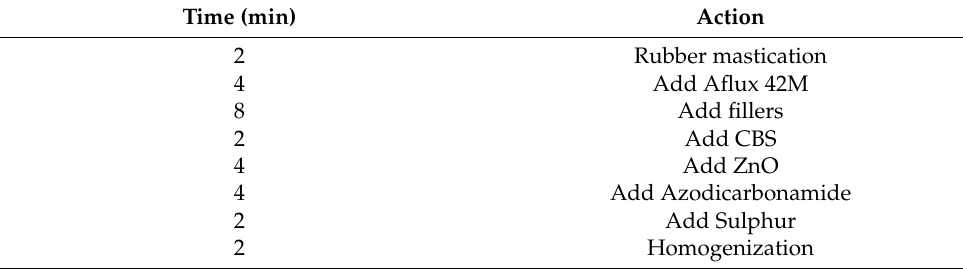
Table 2. Mixing procedure of natural rubber foam compounding